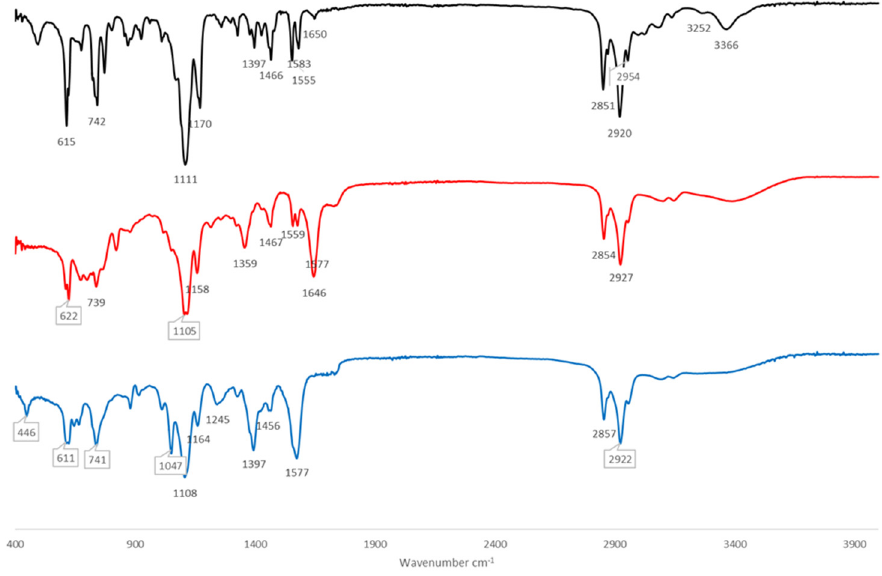
Figure 2. FTIR ATR spectra for CL-4 (black), MR-5 (red), and PR-6 (blue).